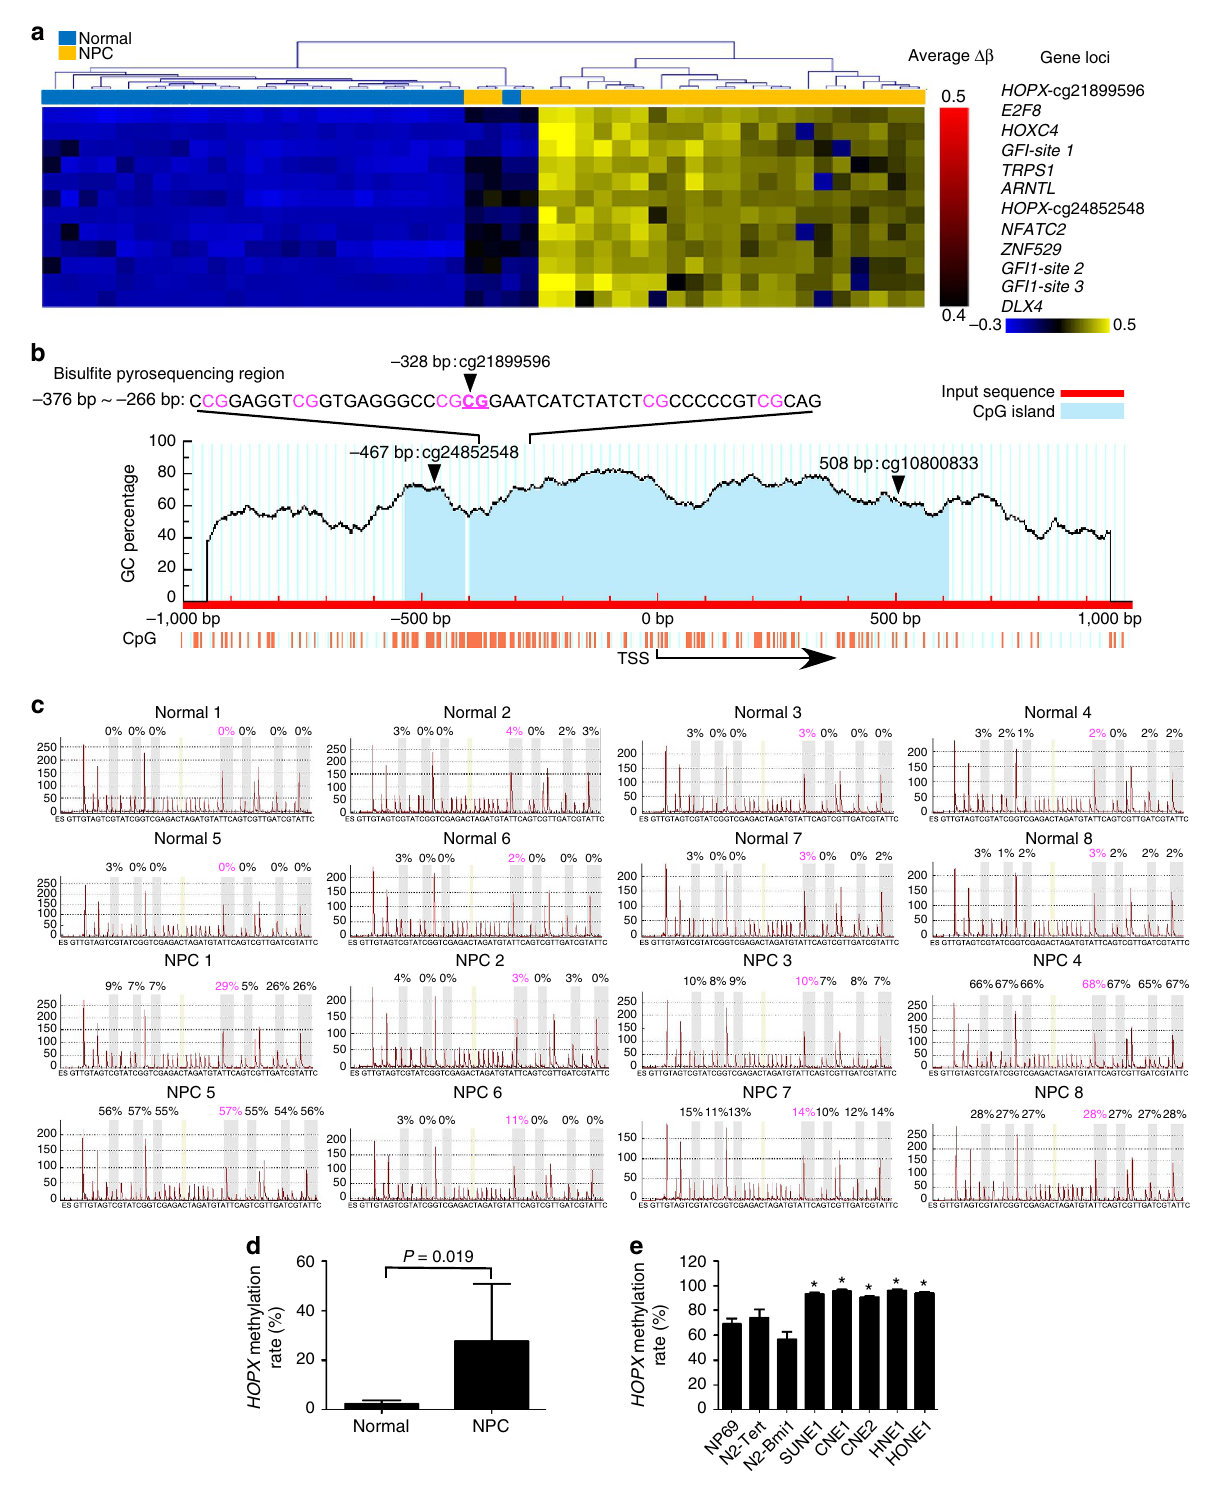
Figure 1 | HOPX is hypermethylated in NPC. ( a ) Heatmap clustering of the top 10 differentially methylated TFs CpG sites in normal nasopharyngeal epithelial tissues (normal, n ¼ 24) and NPC tissues ( n ¼ 24). Columns: individual samples; rows: CpG sites; blue: low methylation; yellow: high methylation. ( b ) Schematic of the CpG islands and bisulfite pyrosequencing region in the HOPX promoter. Input sequence: red region; CpG islands: blue region; TSS: transcription start site; cg21899596, cg24852548 and cg10800833: the CG sites of HOPX identified in our previous genome-wide methylation microarrays; magenta words: CG sites for bisulfite pyrosequencing; bold magenta words: the most significantly altered CG site in HOPX . ( c , d ) Bisulfite pyrosequencing analysis of the HOPX promoter region ( c ) and the average methylation levels ( d ) in normal ( n ¼ 8) and NPC ( n ¼ 8) tissues. Magenta words: CG site of cg21899596. Mean ± s.d.; Student’s t -tests. ( e ) The methylation levels of the HOPX promoter region, as determined by bisulfite pyrosequencing analysis, in NPEC (NP69, N2-Tert and N2-Bmi1) and NPC (SUNE1, CNE1, CNE2, HNE1 and HONE1) cell lines. Mean ± s.e.m.; * P o 0.05 compared with NP69; Student’s t -tests. These data are representative of three independent experiments. NATURE COMMUNICATIONS|8:14053|DOI: